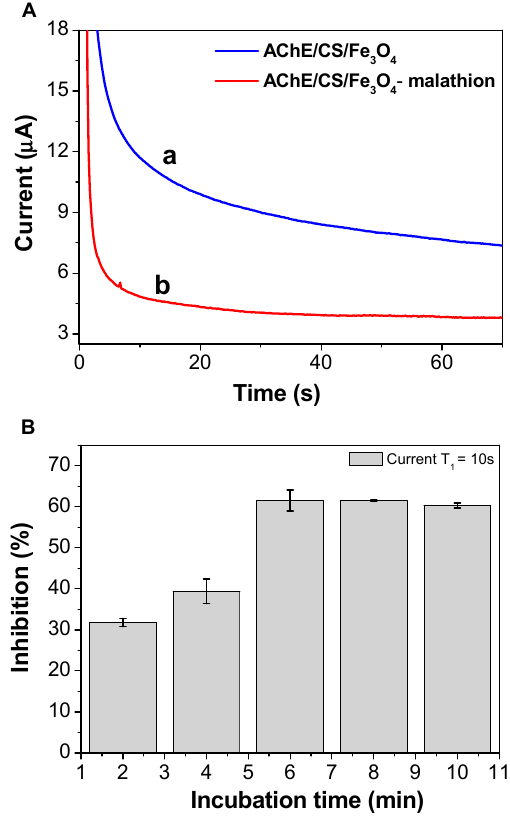
Figure 5. ( A ) Amperograms obtained using the screen-printed carbon electrode modified with AChE/CS/Fe 3 O 4 magnetic nanoparticles (a) before and (b) after inhibition of AChE/CS/Fe 3 O 4 in a solution containing 10 nmol L − 1 of malathion. ( B ) Plot of inhibition (%) of the biosensor modified with AChE/CS/Fe 3 O 4 according to incubation time.